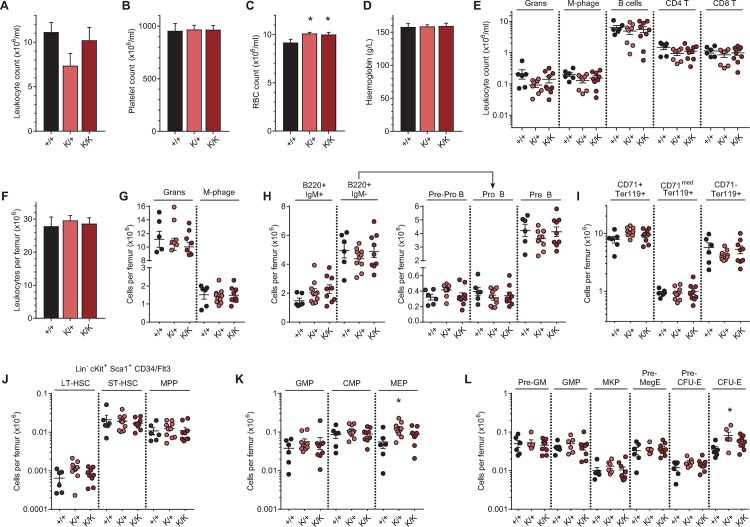
The ATP-dependent helicase function of Recql4 is not required for normal hematopoiesis in vivo.(A) Leukocyte counts in the PB of Recql4+/+, Recql4K52A/+, Recql4K525A/K525A 10-week old mice. (B) Platelet count. (C) Red blood cell count. (D) Hemoglobin. (E) Numbers of granulocytes, macrophages, B cells, CD4 T cells, and CD8 T cells in PB. (F) Leukocyte counts in BM. (G) Absolute numbers of granulocytes and macrophages in BM. (H) Mature (B220+IgM+), immature (B220+IgM-) B lymphocytes, and subsets of immature B lymphocytes per femur. (I) Erythroid fractions based on CD71/Ter119 staining per femur. (J) HSC and primitive progenitors based on Lin-c-kit+Sca-1+CD34/Flt3 staining per femur. (K) Myeloid progenitor subpopulations in the BM. (L) Myeloid, erythroid and megakaryocyte progenitor frequency per femur. Data expressed as mean ± SEM, Student’s t test. *P<0.05; n≥6 per genotype. Experiments were independently executed on separate cohorts, with results pooled for presentation. K = K525A.